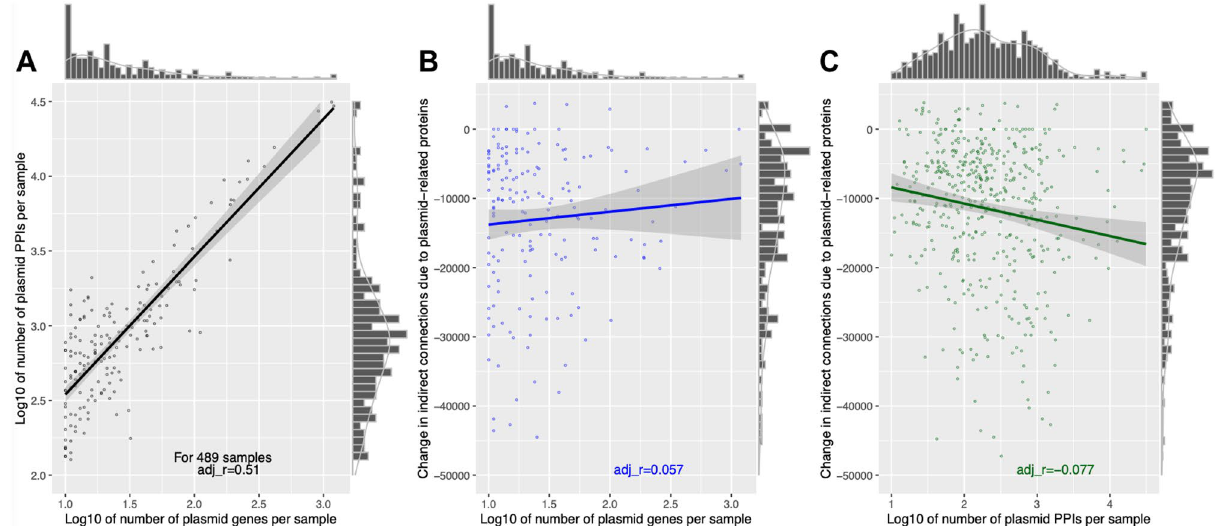
Figure 5. The ( A ) log10-scaled numbers of plasmid-related proteins per sample (x-axis) was positively correlated with the numbers of plasmid PPIs per sample (y-axis) (black, r = 0.51) in the 489 samples with plasmid-related PPIs, but less so with ( B ) the change in the numbers of indirect connections per sample due to the inclusion of the plasmid-encoded proteins (blue, r = 0.06). ( C ) The log10-scaled numbers of plasmid PPIs per sample (x-axis) was negatively associated with the numbers of indirect connections per sample due to the inclusion of the plasmid-encoded proteins (green, r = − 0.08). The lines of best fit for each plot shows the linear correlation of the number of PPIs per sample with the number of indirect connections per protein. The histograms indicate the marginal densities per axis for each